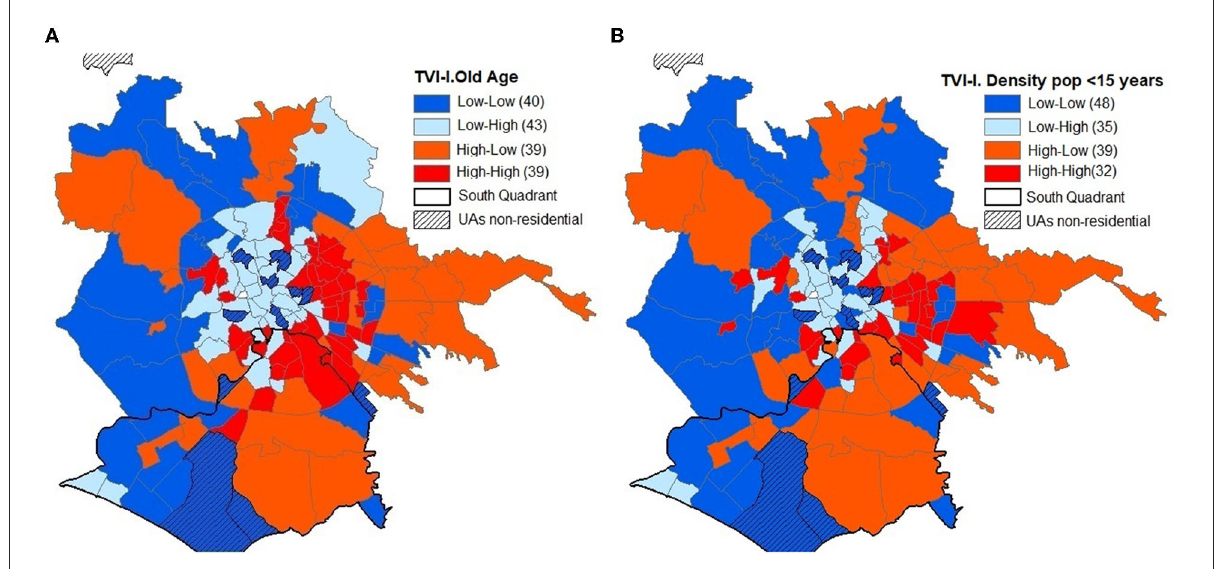
FIGURE5 (A) Spatial and territorial structure between TVI and IV. (B) Spatial and territorial structure between TVI and D.